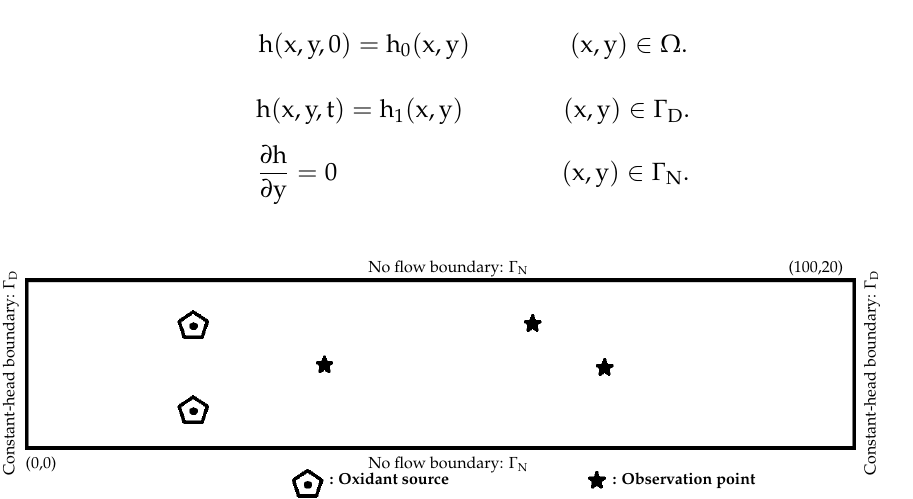
Figure 1. The aquifer domain and physical setting of the model.